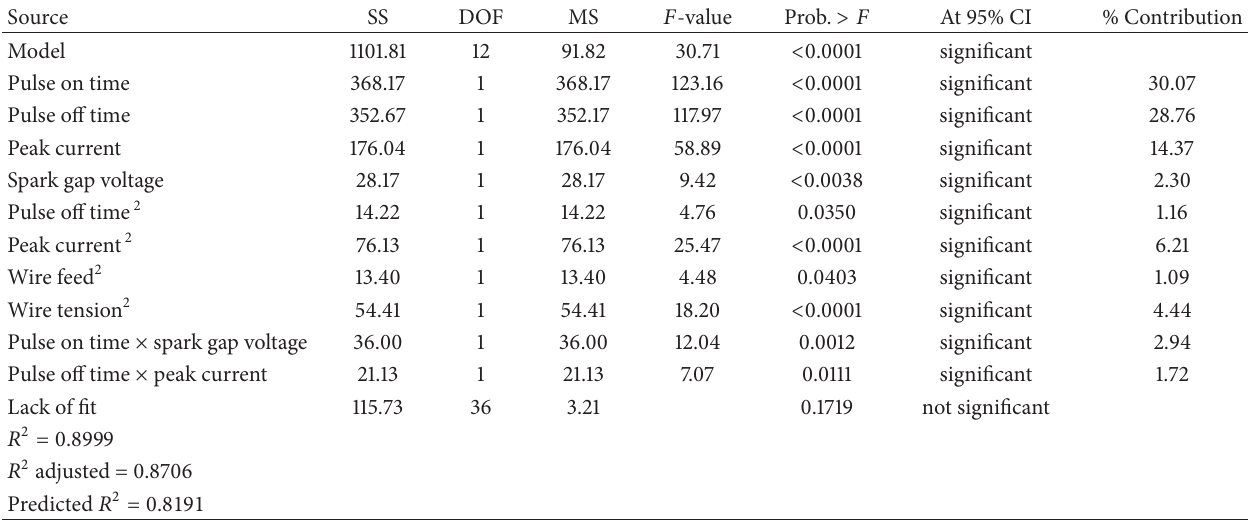
Table 4: The analysis of variance for main and interaction effects of parameters on overcut.